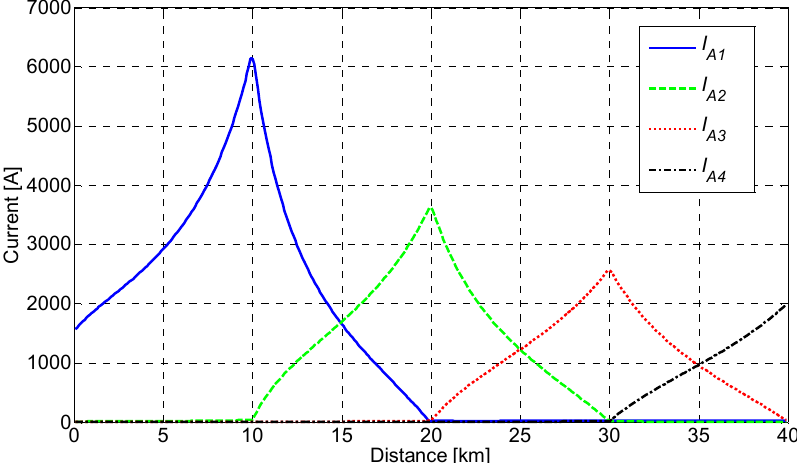
Figure 11. Currents in autotransformers as a function of the distance from the traction substation when a ground fault occurs between the feeder and rail along different zones in a section with four subsections.